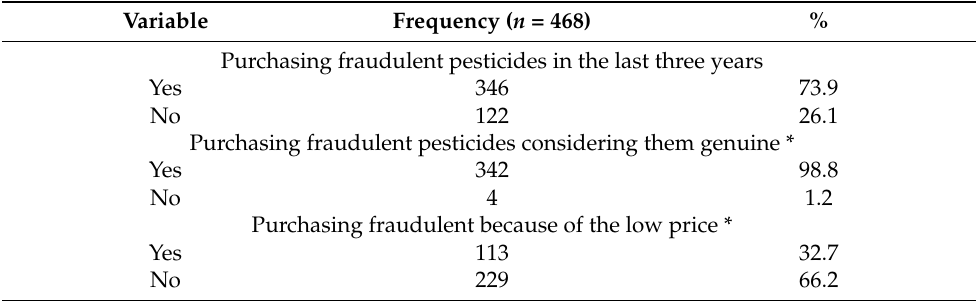
Table 5. Farmers’ purchasing behavior regarding fraudulent pesticides.